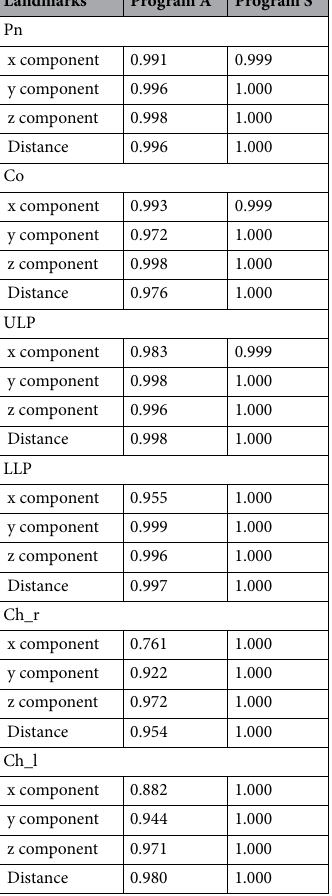
Table 3. The difference in inter-examiner reliability between Program A and Program S. Cronbach’s alpha coefficient was obtained to assess the intraclass correlation coefficient. Pn, Pronasale; Co, Columella; ULP, Upper lip point; LLP, Lower lip point; Ch_r, Cheek right; Ch_l,